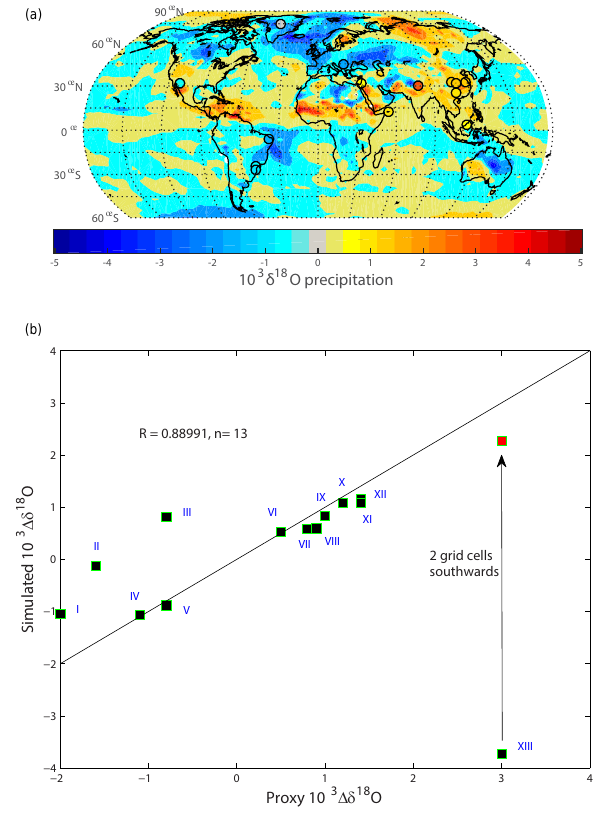
Figure 4. (a) Model–data comparison of δ 18 O precipitation anomaly during HS compared to the LGM. Data represent speleothem’s calcite δ 18 O from various locations (see Table 3 for details). (b) Comparison of reconstructed HS precipitation anomaly (cid:49)δ 18 O from selected proxies shown in (a) and simulated (cid:49)δ 18 O p anomaly ( R = 0 . 89, n = 13). Note that the correlation is done with point XIII corrected, as we assume a bias in the model. Refer to Ta- ble 3 for details on reconstructed precipitation. Points falling on the line depict the same anomaly in the reconstruction and the simula- tion. Note that Timta and Dongge (Wang et al., 2005) Cave δ 18 O c values were estimated from the Younger Dryas excursion, some- times called H0 and characterized by a large freshwater input in the North Atlantic (Pausata et al., 2011).